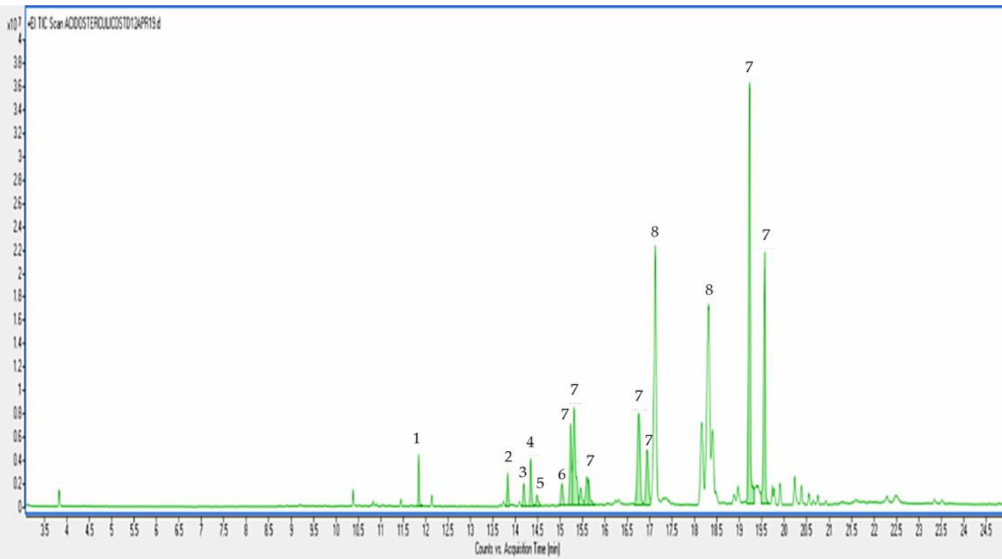
Figure 2. GC-MS chromatogram of methyl esters obtained from the analysis of chemically synthesized sterculic acid after acid esterification. Peaks: (1) palmitic acid (16:0); (2) oleic acid ( cis -9 18:1); (3) stearic acid (18:0); (4) conjugated linoleic acid (18:2); (5) nonadecanoic acid (19:0); (6) CPFA* (m/z 278; M + : m/z 310); (7) CPEFA* (m/z 81; M + : m/z 308); (8) not identified* (m/z 85; M + : m/z 308). *Mass spectrum was compared with NIST 11 mass spectra libraries and mass spectra published for methyl sterculate and methyl dihydrosterculate [2,17].